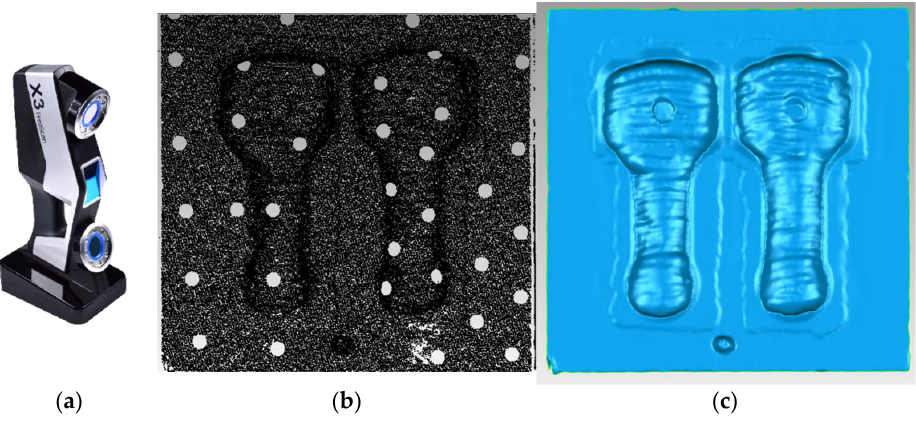
Figure 12. ( a ) Hand-held scanner (Freescan X3); ( b ) point cloud; ( c ) outliers removed and hole filled using Geomagic studio.